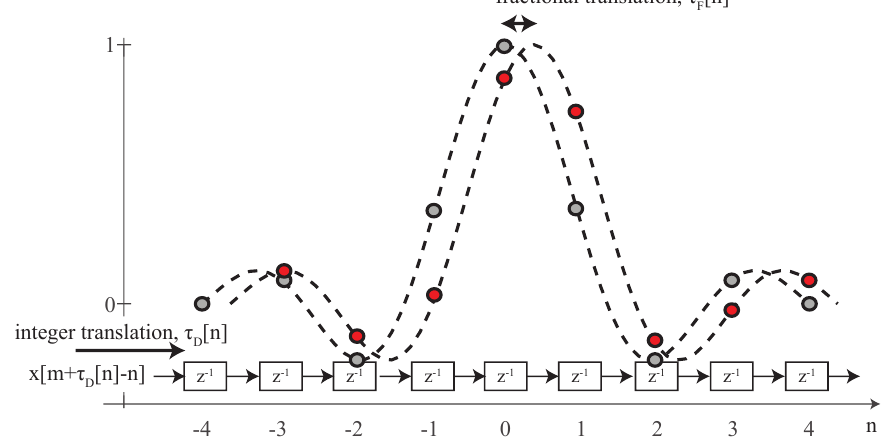
Figure 2. The time-varying fractional delay line: the signal is delayed by the integer value, while the sinc function implements the fractional